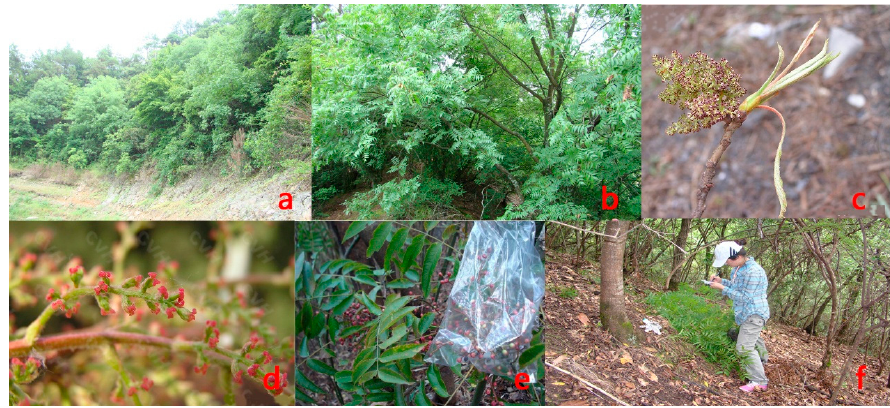
Figure 1. Pistacia chinensis B. ( a ) P. chinensis population, ( b ) P. chinensis tree, ( c ) male flowers, ( d )